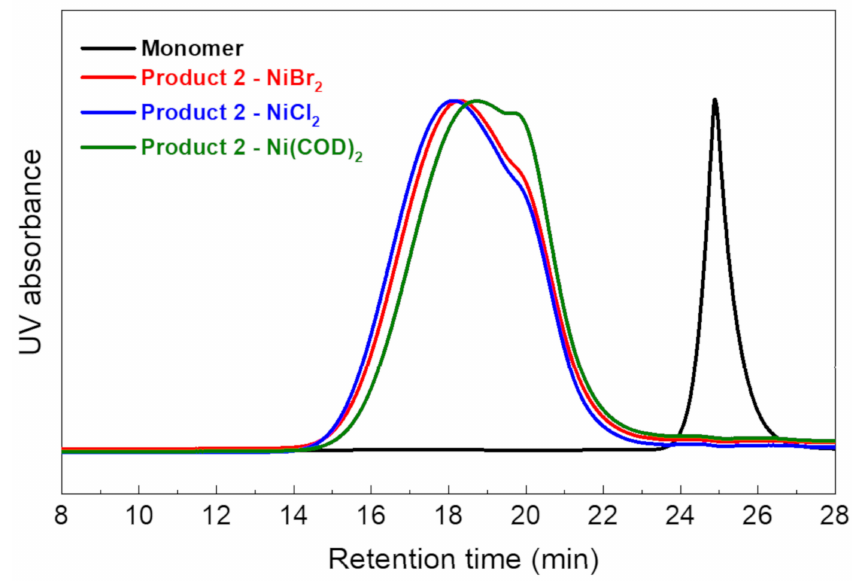
Figure 4. GPC traces of Product 2 with various Ni(0)